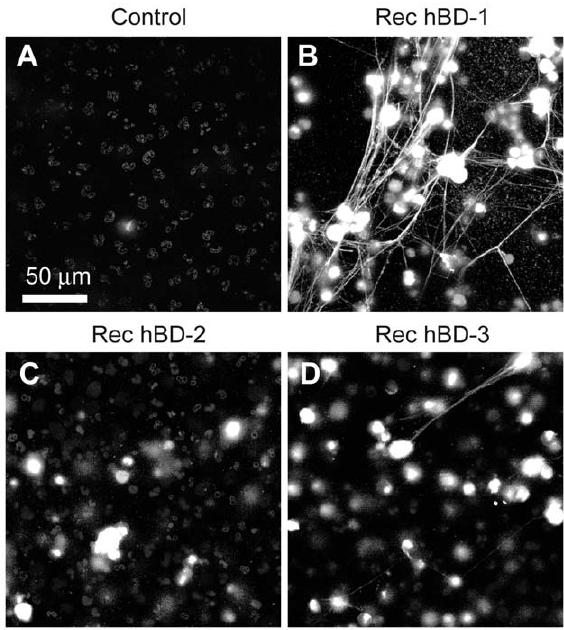
Figure 6. b -defensin 1, but not other b -defensin family members, induce PMNs to form NETs. PMNs were left untreated (control) or incubated with 100 ng/ml of recombinant hBD-1, hBD-2, or hBD-3. After 60 minutes, NETs (arrows) were detected by live cell imaging as previously described[16]. Increasing concentrations of hBD- 2 or hBD-3 failed to induce NET formation (data not shown). Images are representative of three independent experiments.